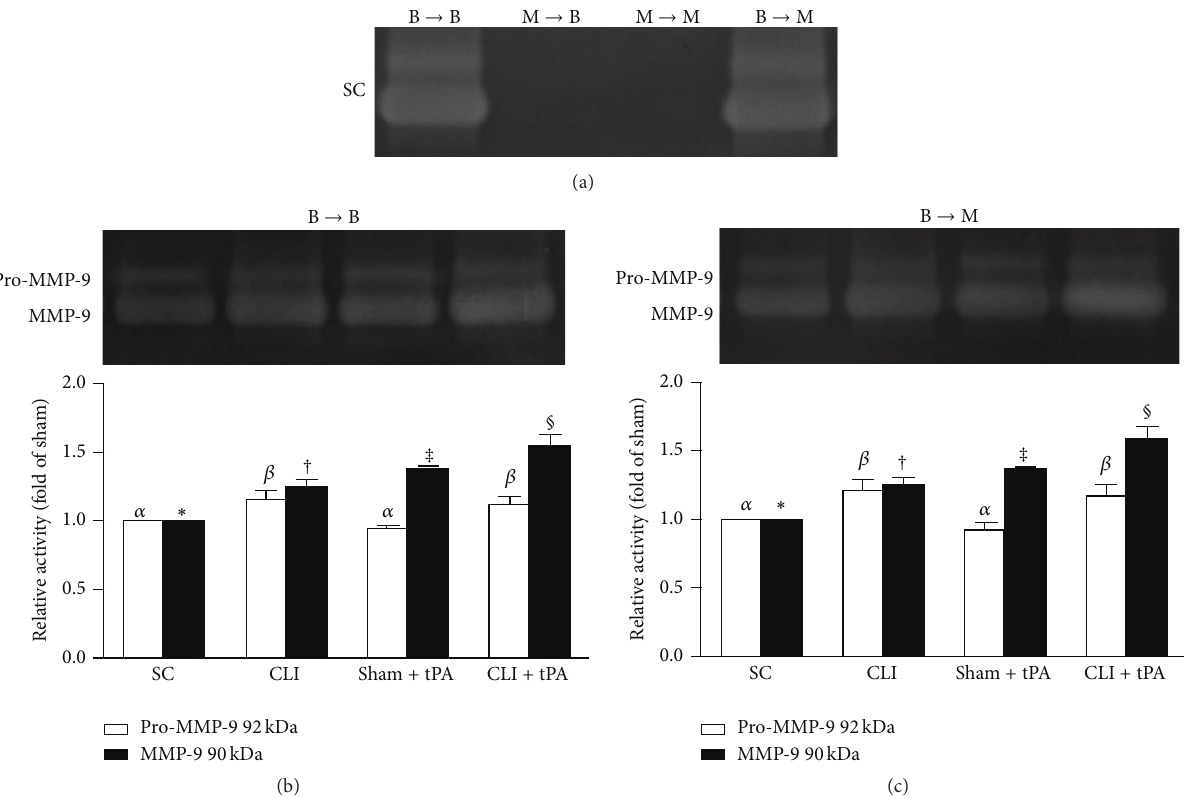
Figure 15: Matrix metalloproteinase- (MMP-) 9 activity in BM by 18 h after CLI procedure. (a) Zymography analysis of matrix metalloproteinase- (MMP-) 9 activity in BM of four groups. No MMP-9 activity was identified in M → M and M → B groups. On the other hand, MMP-9 activity was observed in B → B and B → M groups. (b) (1) Zymography analysis of pro-MMP-9 activity in B → B group of different treatment condition (white bar chart), 𝛼 versus 𝛽 , 𝑝 < 0.05 . (2) Zymography analysis of active form of MMP-9 in B → B group of different treatment condition (black bar chart), subgroups with different symbols ( ∗ , † , ‡ , and §), 𝑝 < 0.05 . Symbols ( ∗ , † , ‡ , and §) indicate significance (at 0.05 level). 𝑛 = 4 for each group. (c) (1) Zymography analysis of pro-MMP-9 activity in B → M group of different treatment condition (white bar chart), 𝛼 versus 𝛽 , 𝑝 < 0.05 . (2) Zymography analysis of active form of MMP-9 in B → M group of different treatment condition (black bar chart), subgroups with different symbols ( ∗ , † , ‡ , and §), 𝑝 < 0.05 . 𝑛 = 4 for each